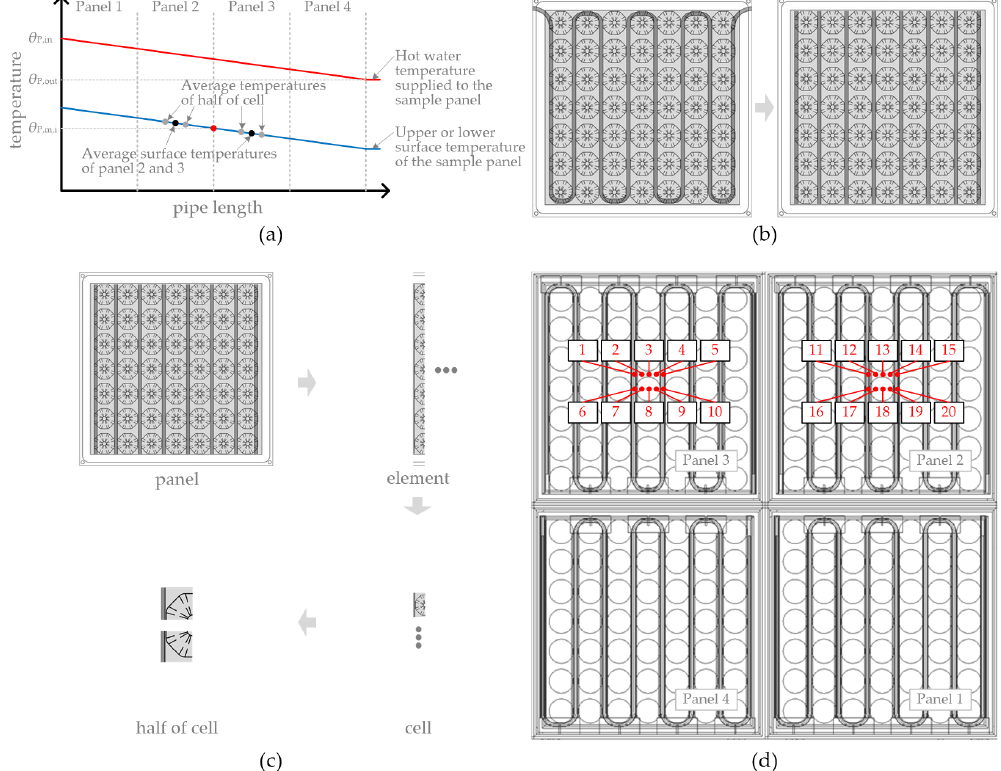
Figure 6. Determination of the position of the thermocouple for the measurements of θ P,m,i : ( a ) Schematic of the measurement of θ P,m,i . ( b ) The curved piping of a RFIRHP is replaced by a straight one. ( c ) The shape of a RFIRHP where the half of cell is repeated. ( d ) The position of the thermocouple in the measurements of θ P,m,i